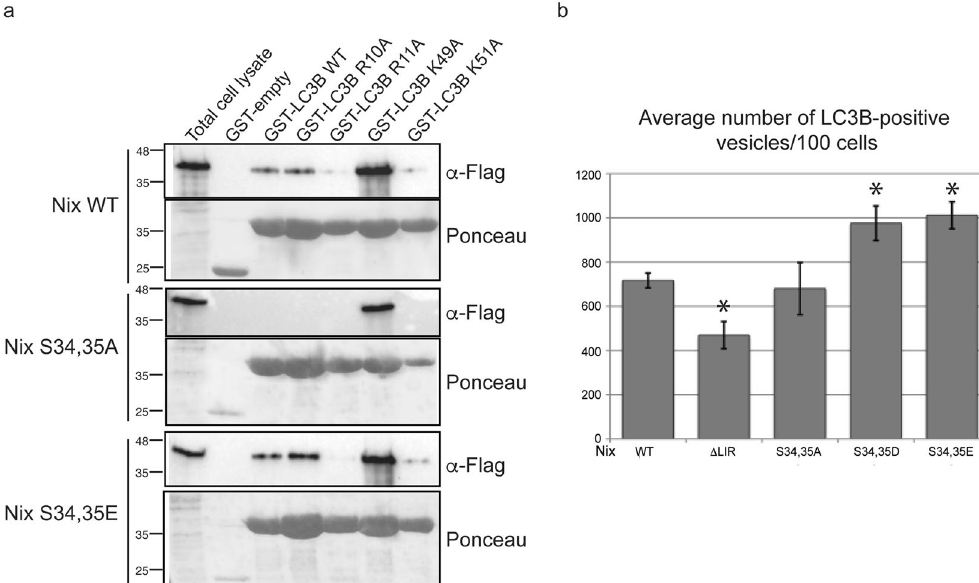
Figure 3. LC3B Arg10, Arg11 and Lys49 residues are important for interaction with phosphorylated Nix. ( a ) GST pull-downs with GST-LC3B wild type GST-LC3B, R10A, R11A, K49A and K51A were performed against Flag-Nix wild type, S34,35A and S34,35E. ( b ) Cells cotransfected with Nix wild type, Δ LIR, S34,35A, S34,35E or S34,35D and GFP-LC3B were screened using immunofluorescent microscopy. Three independent experiments were performed and average numbers of LC3B positive vesicles per 100 cells in each experiment were calculated. Error bars are standard deviation. * Significantly different from the control Nix wild type, p <